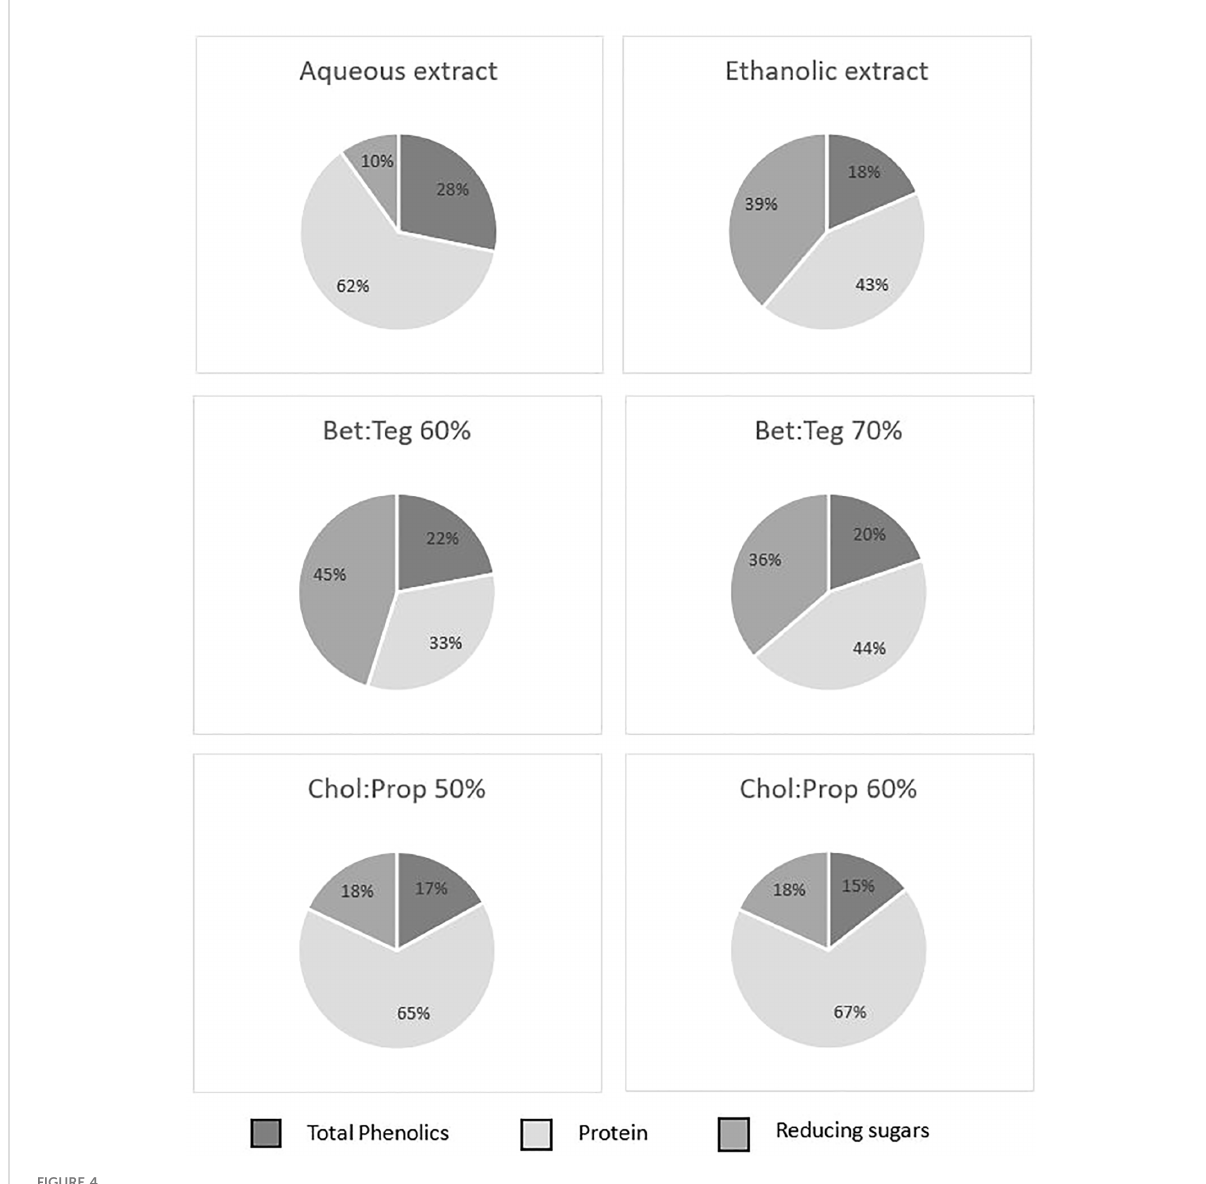
FIGURE 4 Pie charts representing the composition of phenolics, protein, and reducing sugars for each